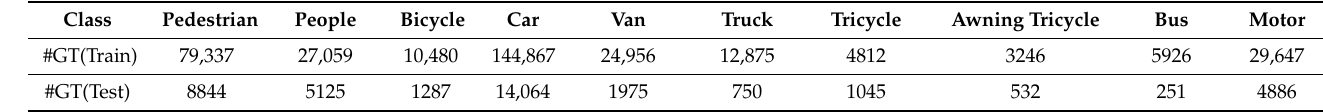
Figure 13. Experimental data sets. ( a ) Visdrone2019-Det; ( b ) SCOD. Table 1. Description of VisDrone-DET2019.